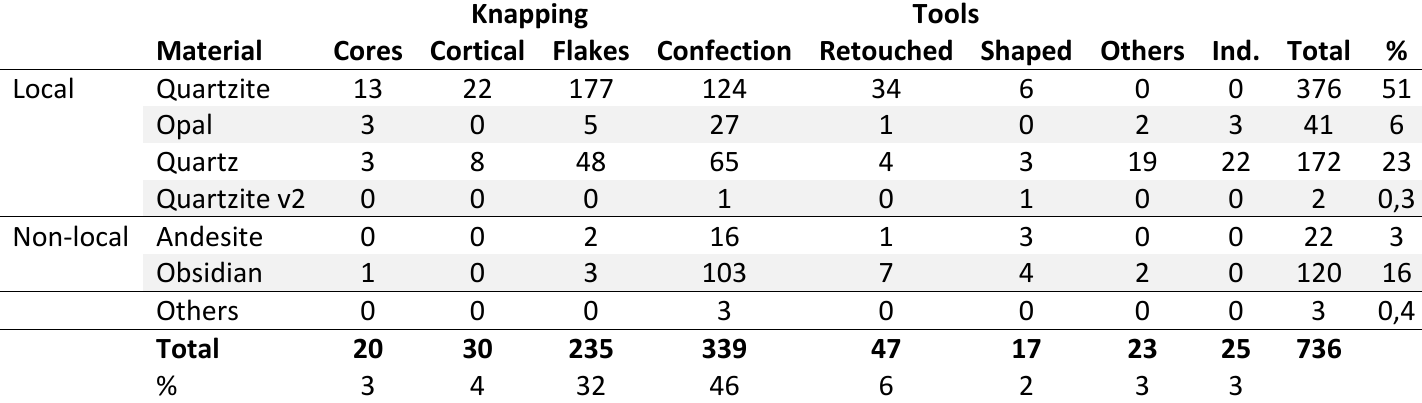
Table 3. Lithic materials of Morro Blanco classified following raw material and chaîne opératoire